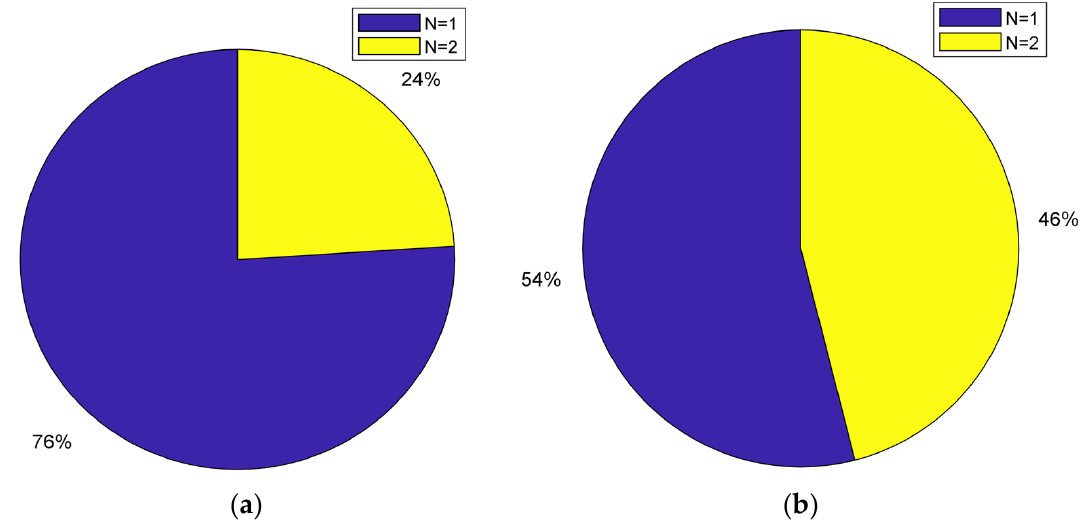
Figure 12. Pie chart of number of branch iterations N . ( a ) 𝒙 (cid:2868) ∈ 𝐷 ; ( b ) 𝒙 (cid:2868) ∈ 𝐷 (cid:3046) .